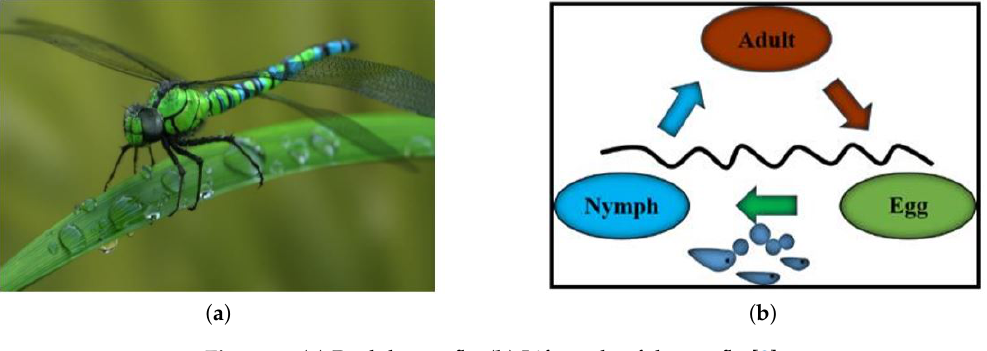
Figure 3. ( a ) Real dragonfly, ( b ) Life-cycle of dragonfly